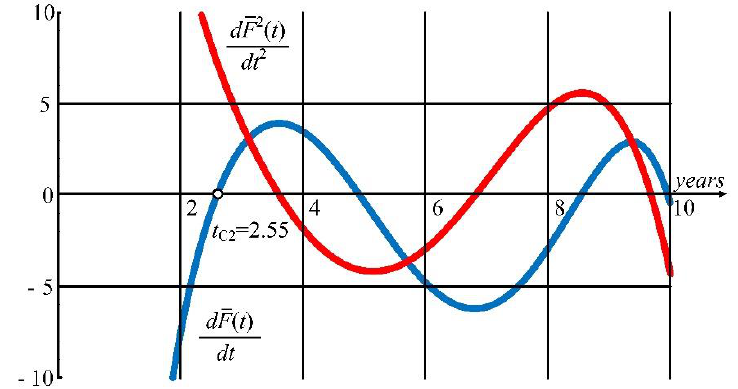
Figure 9. The first and second derivative of a function of average costs for the machine type 2.